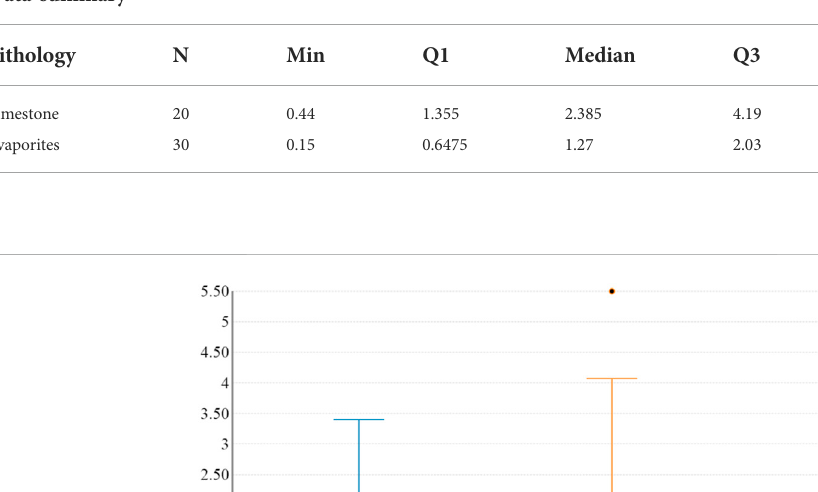
TABLE 2 Statistical data summary.